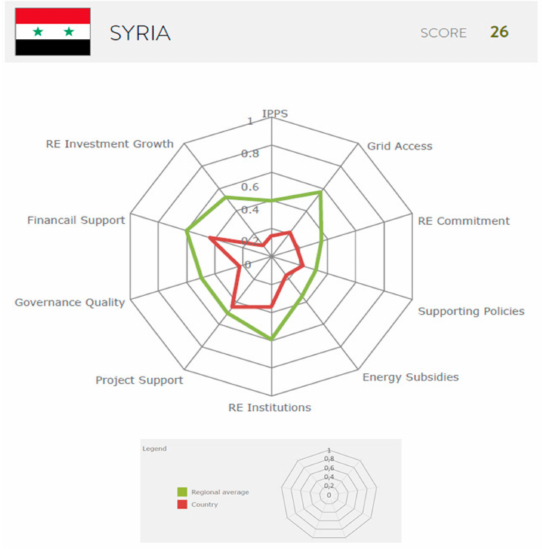
Figure 7. The assessment of Syria’ progress in renewable energy until 2019